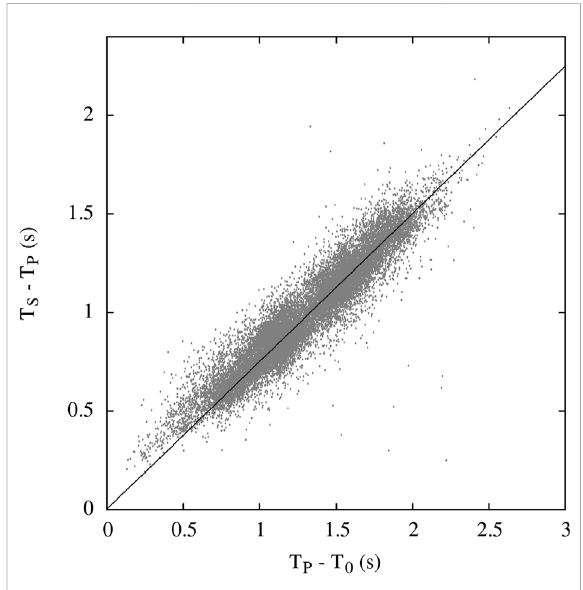
FIGURE 2 Wadati diagram. The difference T S -T P between S-waves (T S ) and P-waves (T P ) travel times, as a function of T P -T 0 (T 0 is the origin time) for the 6,906 events recorded at the 14 available stations. The best fi t line corresponds to v P v